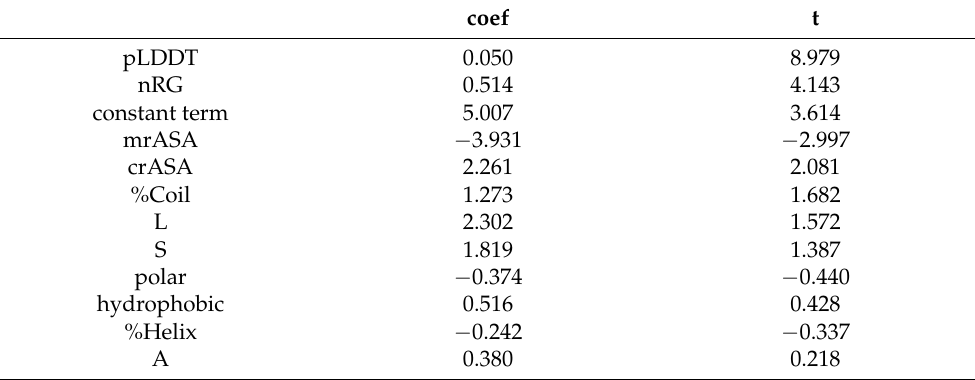
Figure 1. Comparisons of the ProS classes. ( a ) Distributions of RMSDs between the experimental structures of ProSs and the corresponding regions in AF2 models for the excellent, average, and poor classes. The excellent and average classes and average and poor classes were divided by RMSDs of 1.76 and 4.13 Å, respectively. ( b ) Distributions of averaged pLDDT over the ProS regions in AF2 models for the excellent, average, and poor classes. Double asterisks (**) represent a significant difference between a pair of distributions with a p -value less than 0.01, with the Mann– Whitney U -test. Table 1. Contribution of each feature to the regression